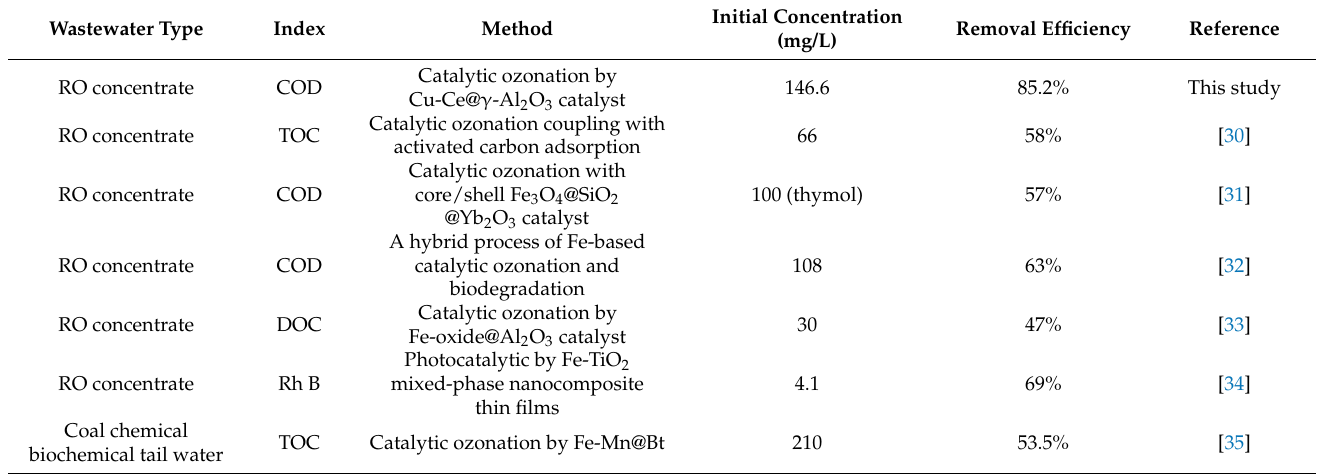
Table 5. Treatment of wastewater with different catalytic oxidation